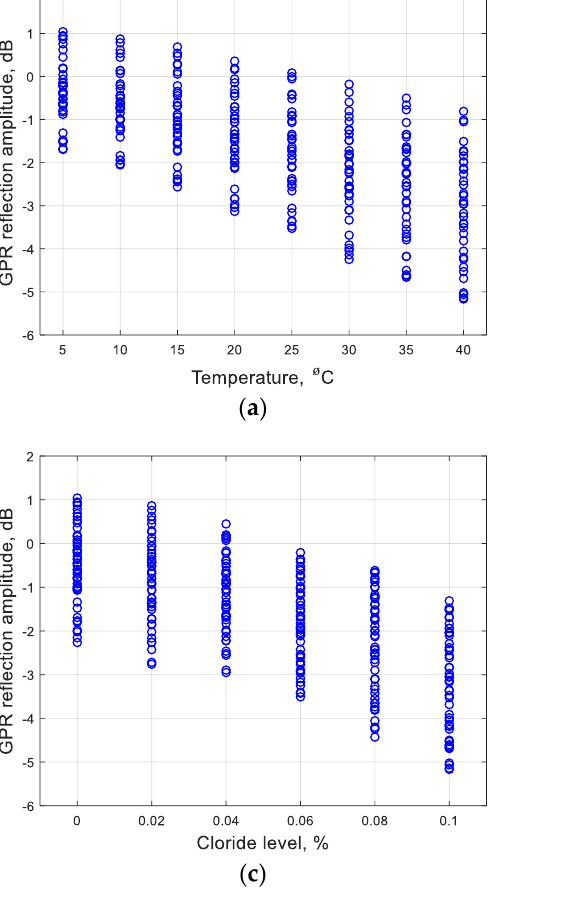
Figure 5. Input and output relationship of the experimental data: ( a ) Temperature; ( b ) Relative humidity; ( c ) Chloride contamination level; ( d ) Rebar corrosion status.